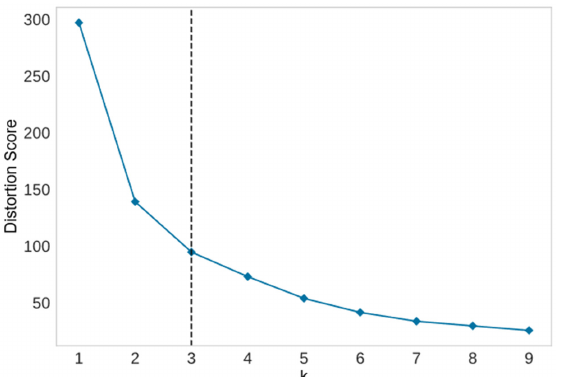
Figure 6. Theoptimal numbers of clusters calculated with the elbow method.